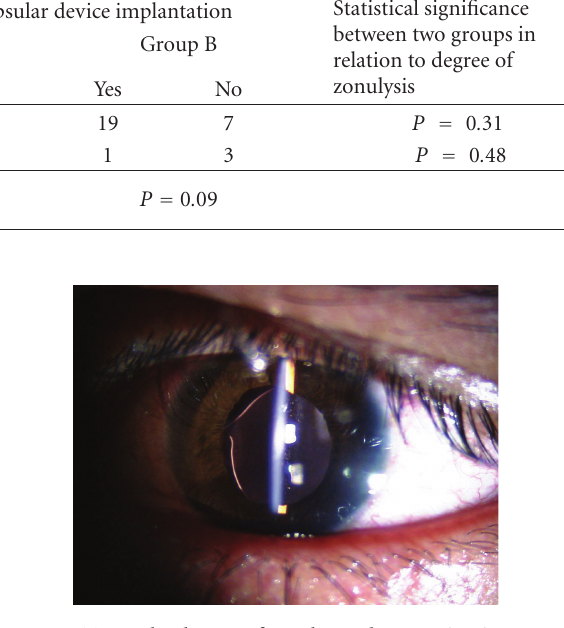
Figure 2: Transscleral suture fixated IOL decentration in group